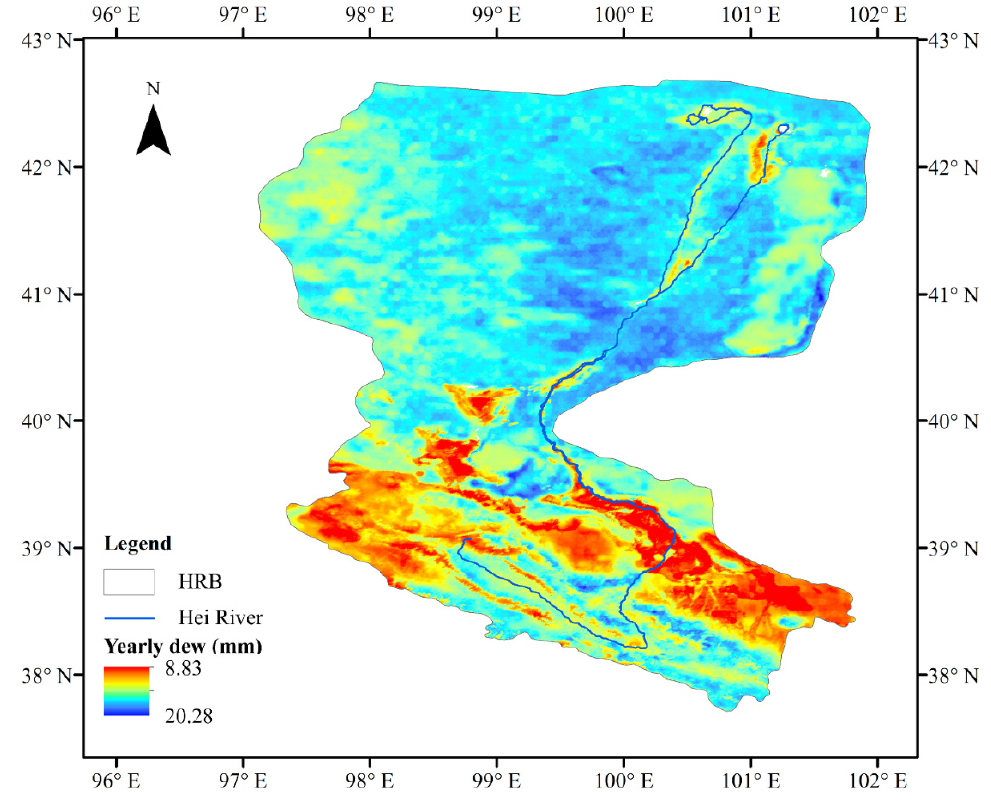
Figure 9. Basin-scale average dew of each month for 2013–2017 estimated using SVM.